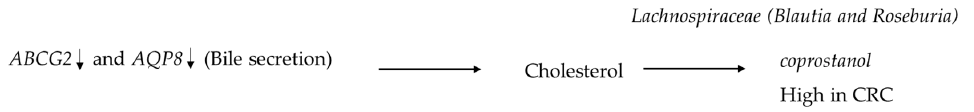
Figure 6. ABCG2 and AQP8 genes are responsible for bile secretion and bile is converted to cholesterol by the gut enzymes [63]. Cholesterol is further converted to coprostanol by members of the Lachnospiraceae family [64].